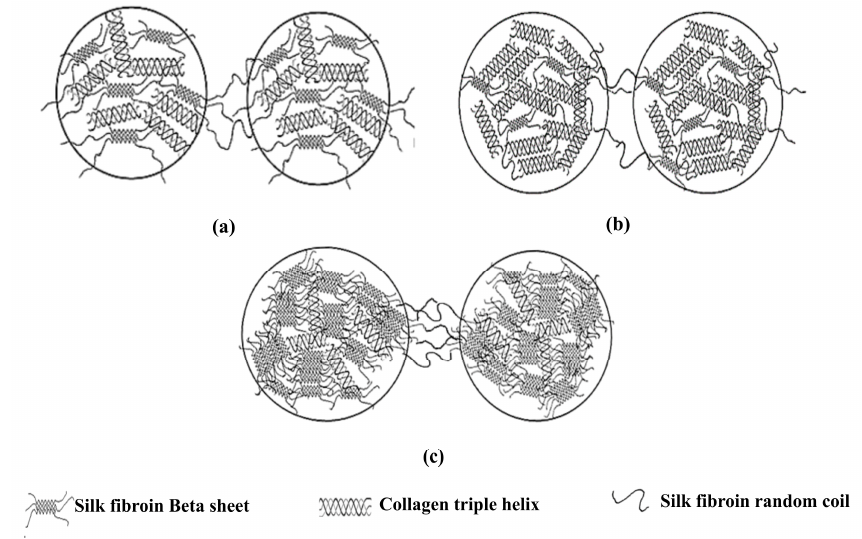
Figure 8. Schematic diagram of a hypothesized model for protein conformational changes in the two adjacent coacervate aggregates of collagen/RSF mixtures after dialysis with different starting ratios of: ( a ) Col/RSF: 75/25; ( b ) Col/RSF: 50/50; and ( c ) Col/RSF: 25/75.